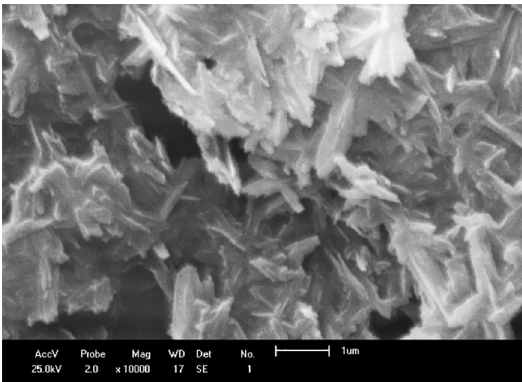
Figure 5. Image obtained by SEM for CuNa05 sample ZONH5 10.000 times.